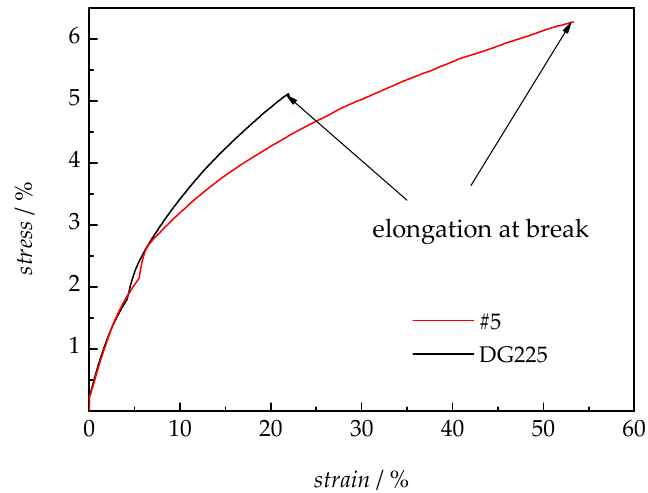
Figure 7. Mechanical stability of the crosslinked PEM #5 and a PEM synthesized without crosslinker (DG225).